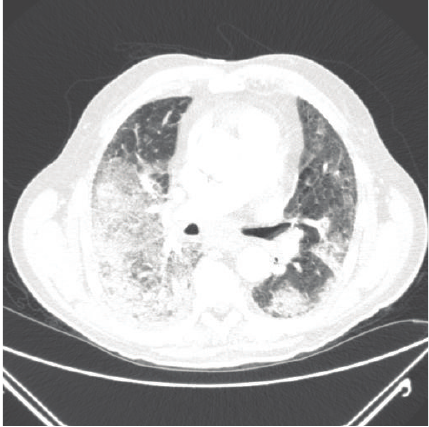
Figure 3: Computed tomography on admission showing bilateral pulmonary